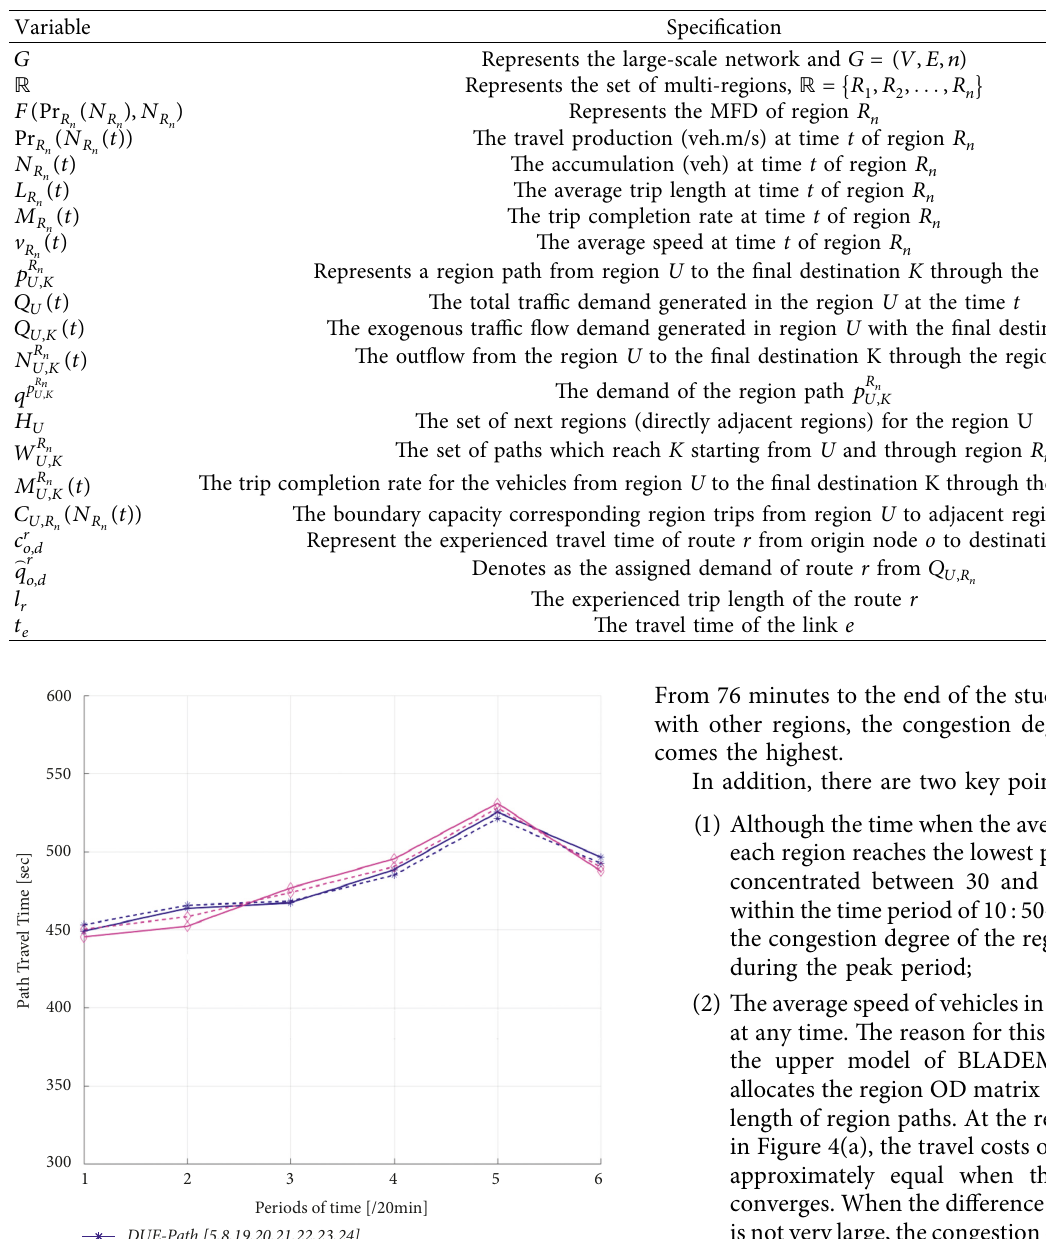
Table 1: Notation